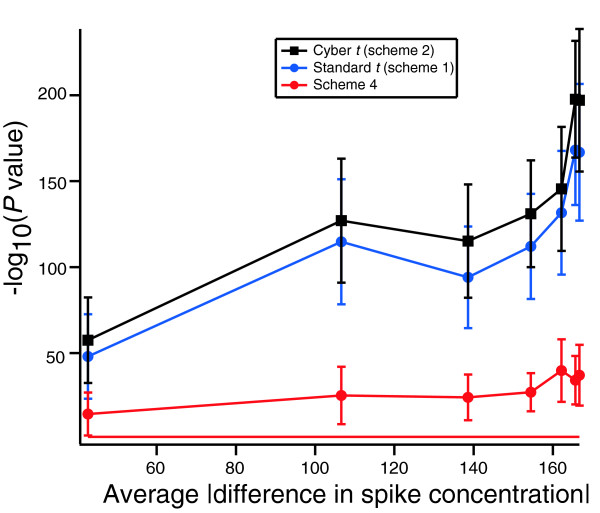
Cross-hybridization distorts P values for null genes in the Latin Square dataset. Shown are the results of the Kolmogorov-Smirnov test for the null genes for all 91 Latin Square comparisons as a function of the average difference in spike concentration (see text). The null hypothesis for the Kolmogorov-Smirnov test is that the observed P values are identical to a uniform distribution. Error bars are standard errors. The red line is the P = 0.05 level.